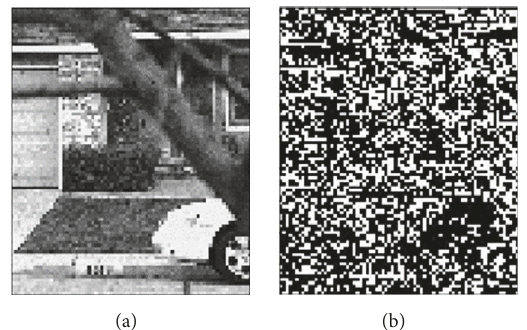
Figure 6: Source and normalized images of the house (CVs). The original colour image “house crop” is available “for free” at the website by T. Georgiev